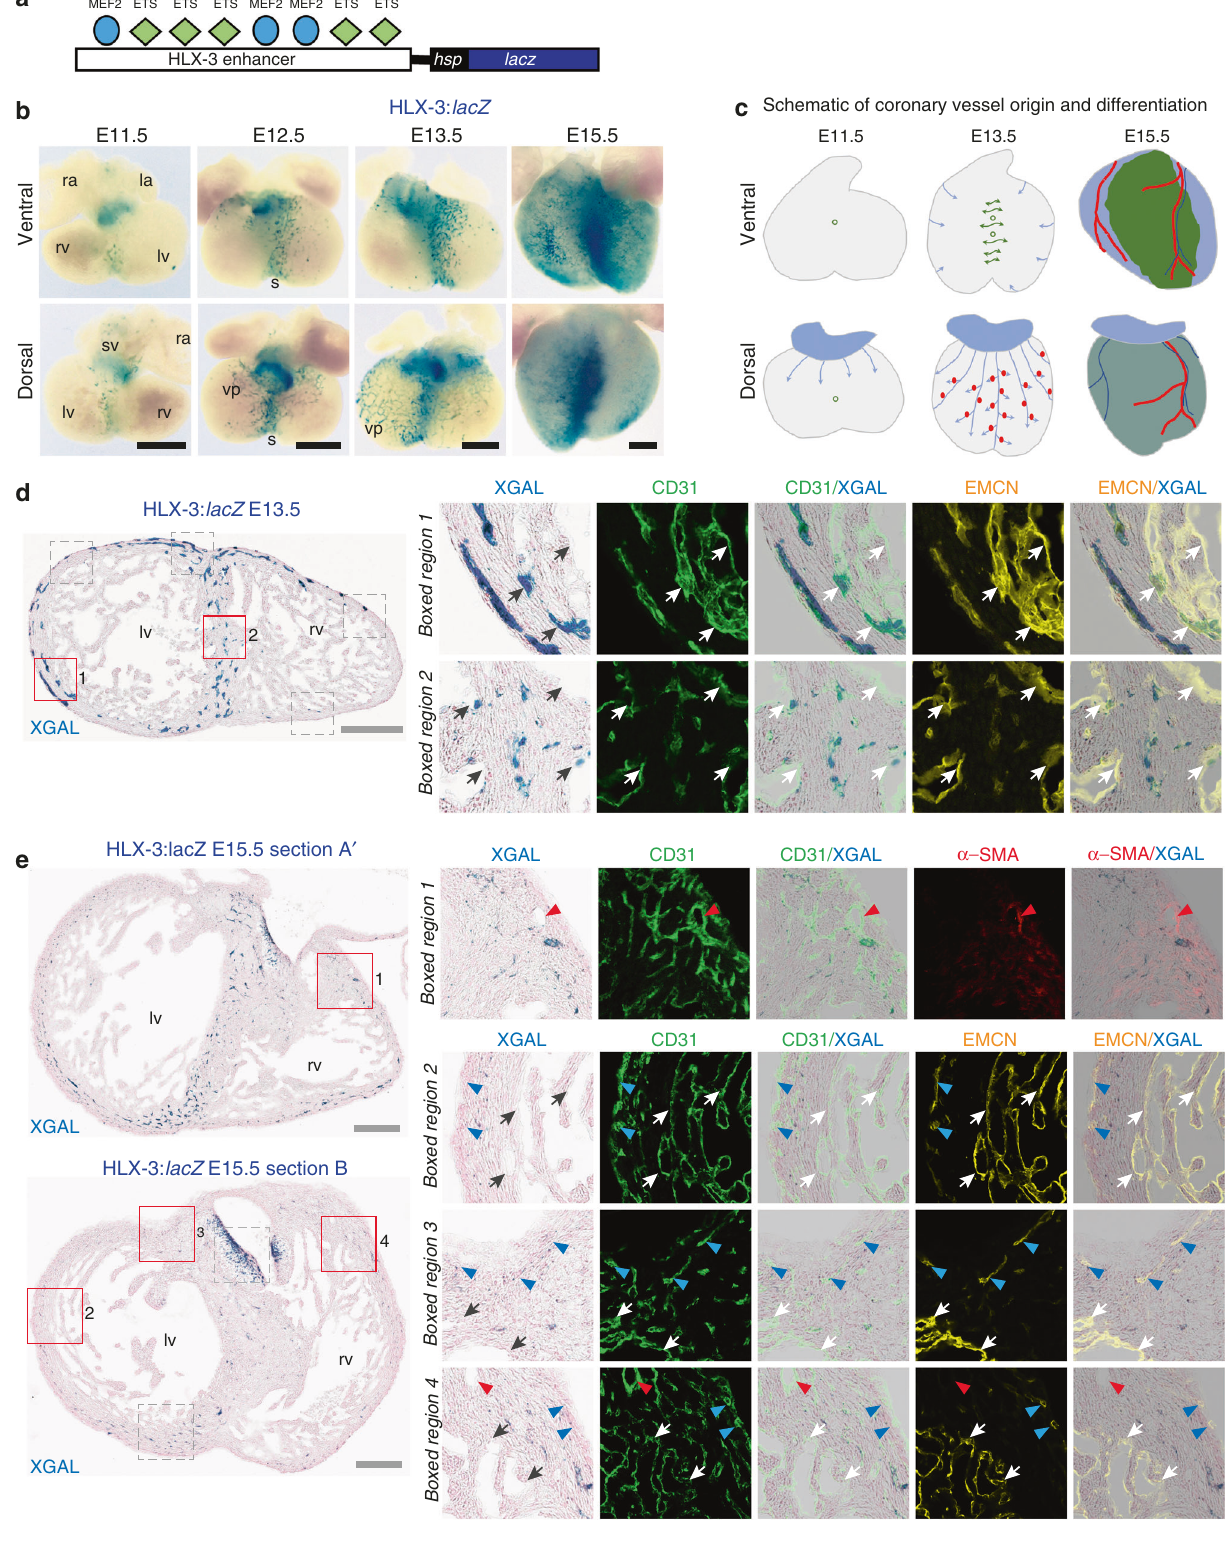
development (Fig. 1b – e and Supplementary Figs. 3 and 4). The activity of HLX-3 was similar in four different independent transgenic lines (Supplementary Fig. 5). In contrast with embryonic hearts transgenic for the ApjCreER;Rosa mTmG line- age 10 , which marks the SV-derived coronary vasculature, very